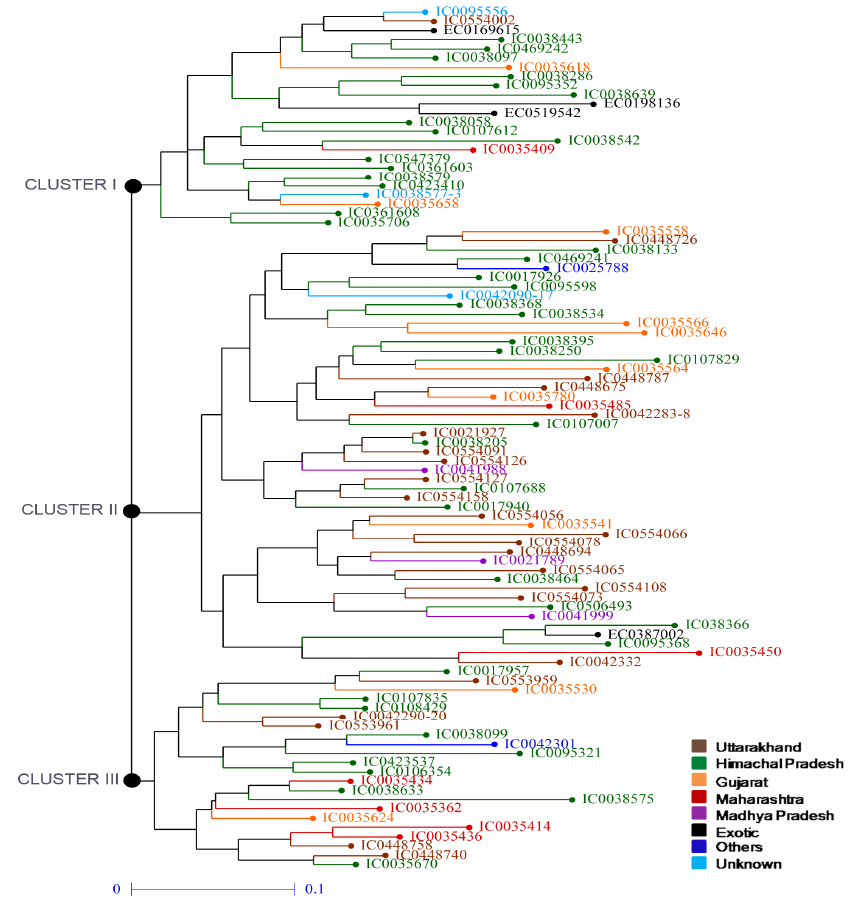
Figure 2. Neighbor-Joining tree analysis across 94 accessions of A. hypochondriacus. Three major clusters were observed. Different colors denote the accessions belonging to different states.